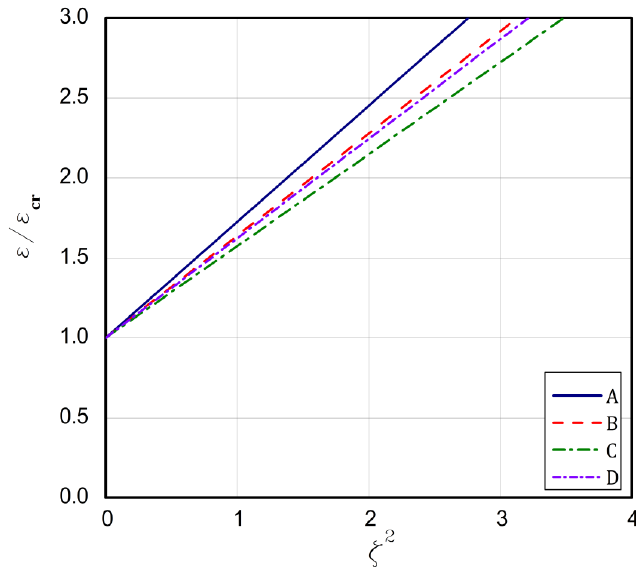
ζ 2 for type 2 of loads of the perfect plates. in a function of 2  for type 2 of loads of the perfect plates. Figure 4. The post-buckling paths ε / ε cr  / cr in a function of ∗ = 0.0 in Equation (3)) are